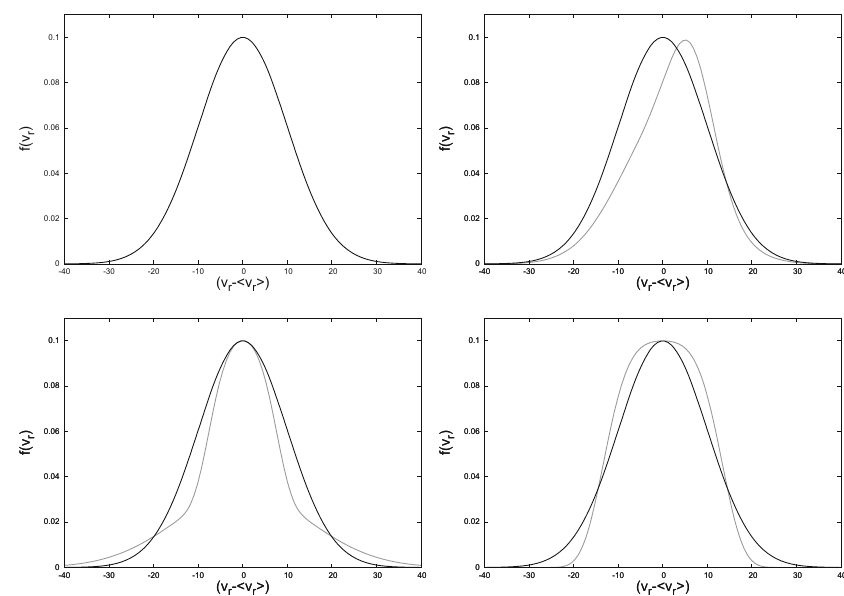
Fig. 64 One-dimensional velocity distribution functions for different cases. Upper panels: from the left to the right, I first show the Gaussian velocity distribution describing thermodynamical equilibrium with a variance of σ = 10 km s − 1 . The Gaussian appears in the subsequent panels for comparison (black). On the right, velocity distribution (grey) with a skewness in positive v r -direction indicating energy flow in v r -direction. Lower panels: two velocity distributions (grey) with an excess and the deficit of high velocity stars, respectively, as compared to a situation of thermodynamical equilibrium